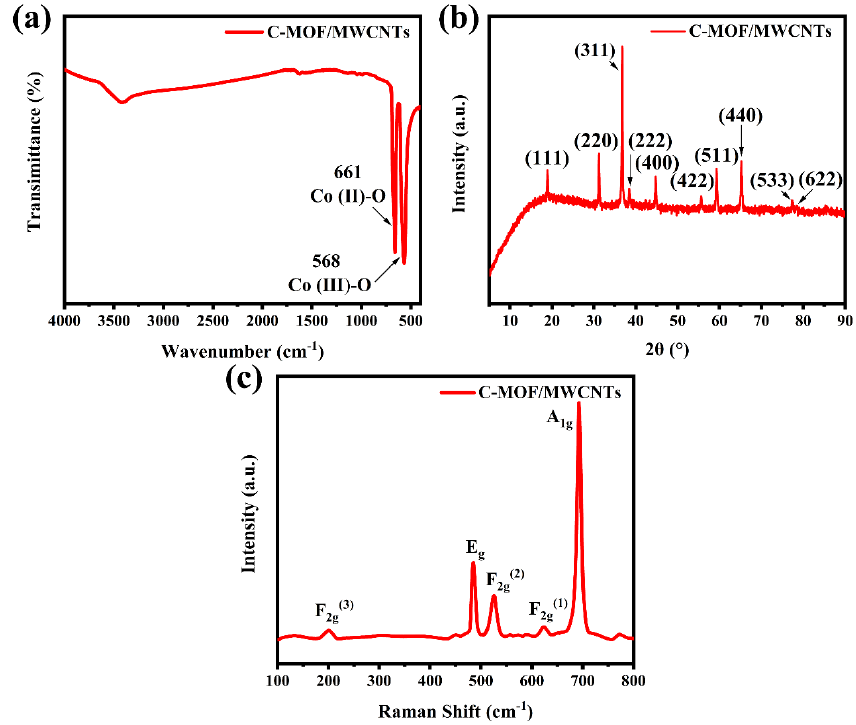
Figure 1. FT - IR spectrum ( a ), XRD curve ( b ), Raman curve ( c ) of C-MOF/MWCNTs. Figure 1. FT-IR spectrum ( a ), XRD curve ( b ), Raman curve ( c ) of C-MOF/MWCNTs. X-ray photoelectron spectroscopy (XPS) curves of C-MOF/MWCNTs, its Co2p and Cu2p X-ray photoelectron spectroscopy (XPS) curves of C-MOF/MWCNTs, its Co2p and were present in Figure 2a–c, respectively. Compared with XPS curves of MOF/MWCNTs Cu2p were present in Figure 2a–c, respectively. Compared with XPS curves of (see Figure S2 in Supplementary Materials [16–24]), the peak of N1s vanished in Figure 2a, MOF/MWCNTs (see Figure S2 in Supplementary Materials [16–24]), the peak of N1s which was assigned to the thermal decomposition of 2-MIM of MOF/MWCNTs in the vanished in Figure 2a, which was assigned to the thermal decomposition of 2-MIM of period of calcination in air. The proportion of specific elements of MOF/MWCNTs and MOF/MWCNTs in the period of calcination in air. The proportion of specific elements of C-MOF/MWCNTs were shown in Table S3. As shown in Table S3, the proportion of C and MOF/MWCNTs and C-MOF/MWCNTs were shown in Table S3. As shown in Table S3, N atoms decreased, and the proportion of O, Co, and Cu atoms increased. The proportion of the proportion of C and N atoms decreased, and the proportion of O, Co, and Cu atoms C atoms did not decrease significantly, and still accounted for 70% of the atomic proportion, increased. The proportion of C atoms did not decrease significantly, and still accounted which was caused by the large amount of MWCNTs contained in C-MOF/MWCNTs, because for 70% of the atomic proportion, which was caused by the large amount of MWCNTs the mass loss of MWCNTs almost did not occur when calcined in air atmosphere of 500 ◦ C. contained in C-MOF/MWCNTs, because the mass loss of MWCNTs almost did not occur The reason for the increase in the proportion of O atoms was that MOF reacted with oxygen when calcined in air atmosphere of 500 °C. The reason for the increase in the proportion to form CO 3 O 4 and CuO during the calcination in air atmosphere. The XPS spectrum of of O atoms was that MOF reacted with oxygen to form CO 3 O 4 and CuO during the Co2p showed two characteristic peaks and two satellite peaks [25,26]. The peak of Co2p 3/2 was divided into two peaks with the binding energies of 778.5 eV and 780.6 eV for Co 3+ 2p 3/2 and Co 2+ 2p 3/2 species, respectively. The peak of Co2p1/2 was divided into two peaks at around 793.4 eV and 795.5 eV, respectively, which belong to Co 3+ 2p 1/2 and Co 2+ 2p 1/2 species. The results of Figure 2b displayed the coexistence of Co 3+ and Co 2+ in C-MOF/MWCNTs. The Cu2p XPS spectrum (Figure 2c) exhibited four peaks at near 933.8 eV, 942.6 eV, 953.8 eV, and 953.6 eV, which were assigned to Cu2p 3/2 , the satellite peak of Cu2p 3/2 , Cu2p 1/2 , and the satellite peak of Cu2p 1/2 [15]. Evidently, compared with the Cu2p XPS spectrum of MOF/MWCNTs (Figure S2c), the Cu2p XPS spectrum of C-MOF/MWCNTs fit more precisely because of the increased atomic ratio of Cu via the calcination of